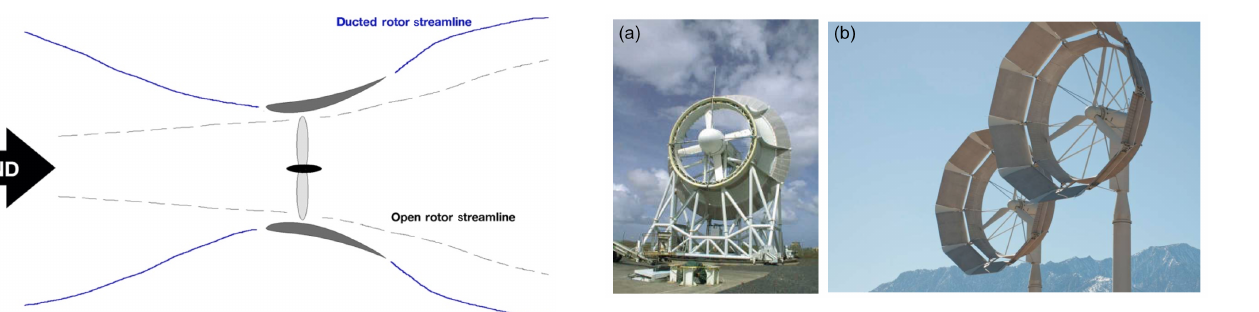
Figure 1. Stream tube capture regions for open rotor and a ducted rotor turbines.